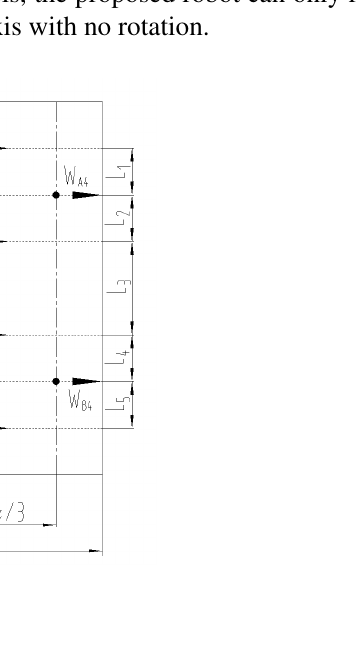
Fig. 3 Rotation of driving wheels around the pipe